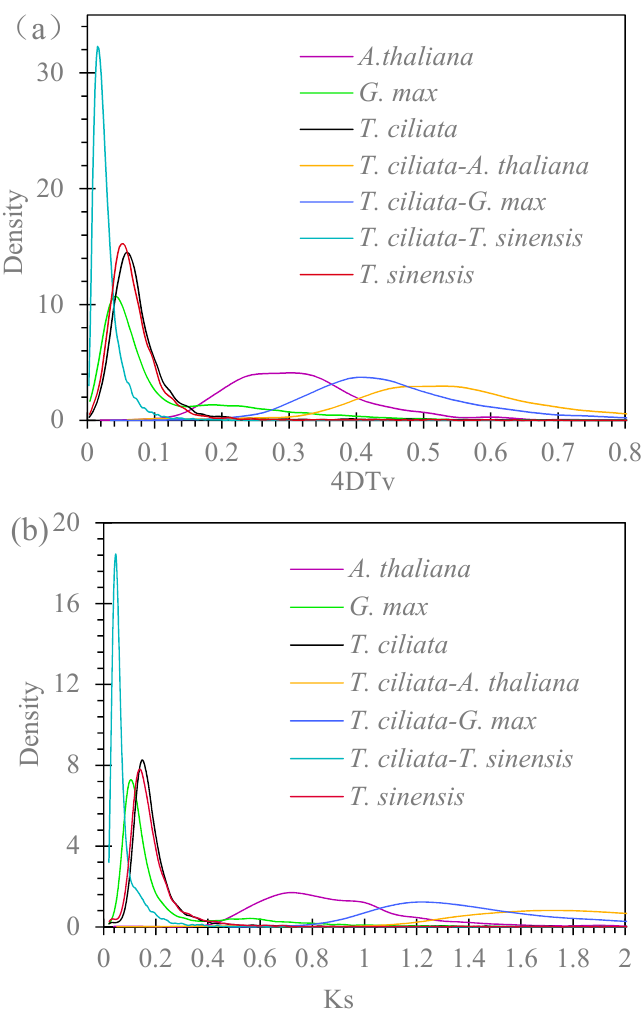
Figure 4. Evolutionary divergence in terms of whole genome duplication (WGD): ( a ) Distribution of 4DTv (four-fold degenerate transversion rate) within and between species genomes; ( b ) Distribution of K s (synonymous substitution rate) within and between species